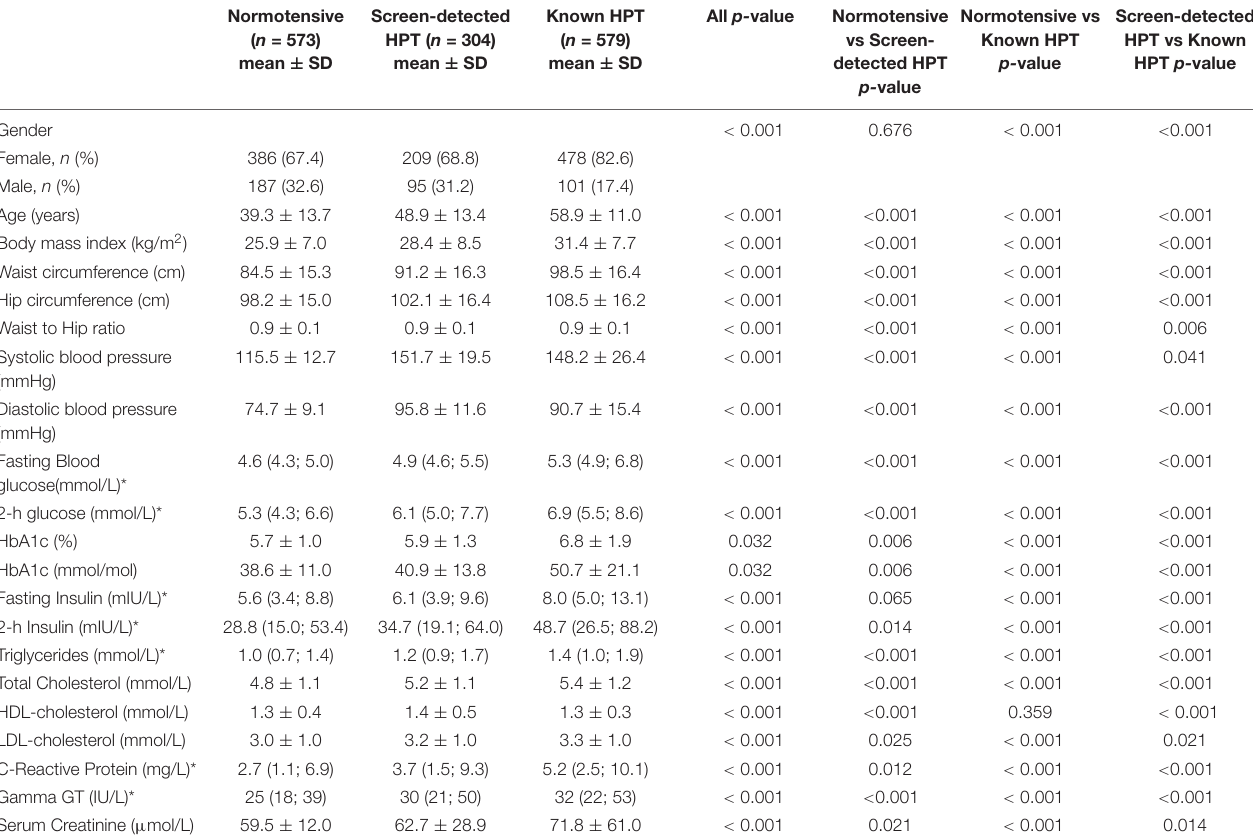
TABLE 1 | Study participant characteristics based on blood pressure